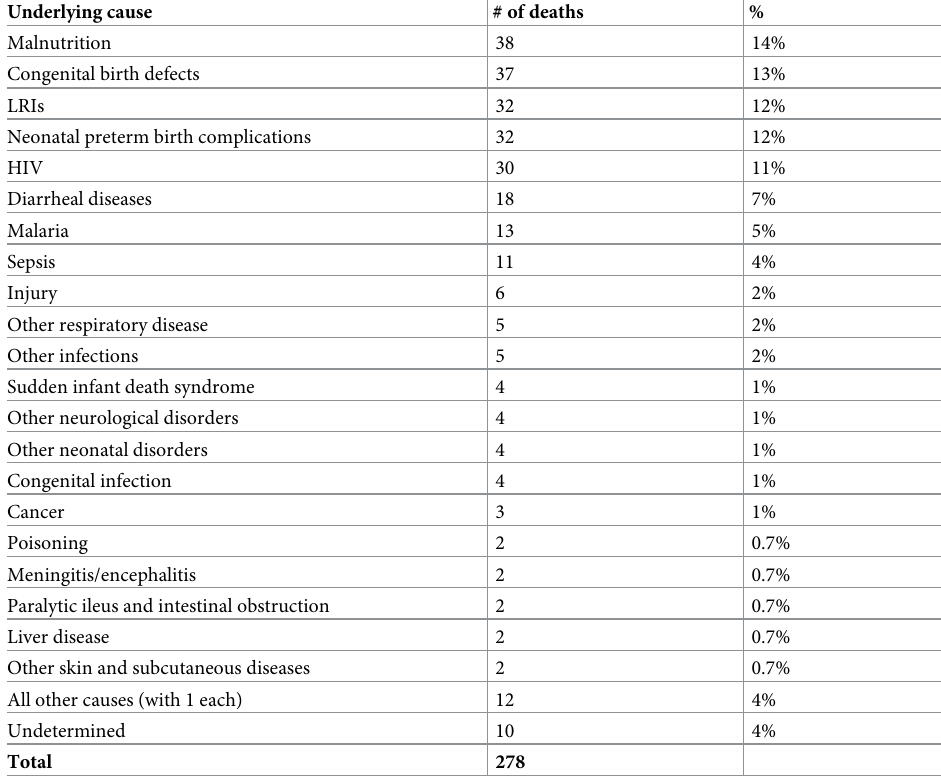
Table 2. Underlying causes for 278 infant deaths.